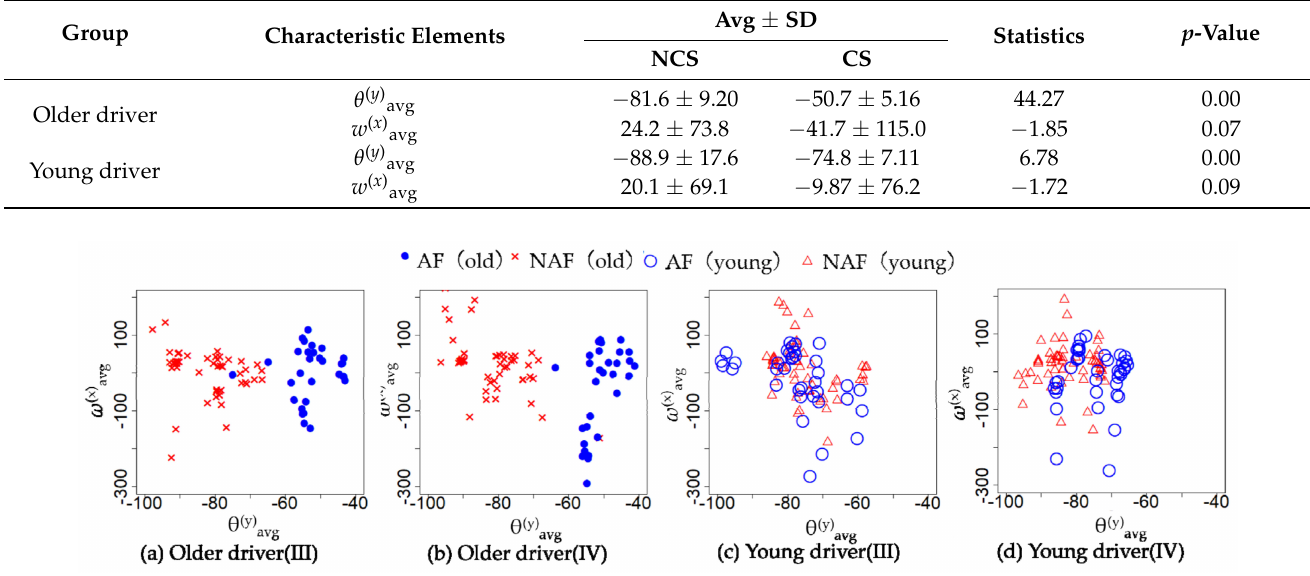
Table 12. Behavioral characteristics of NCS and CS groups in Experiment IV.